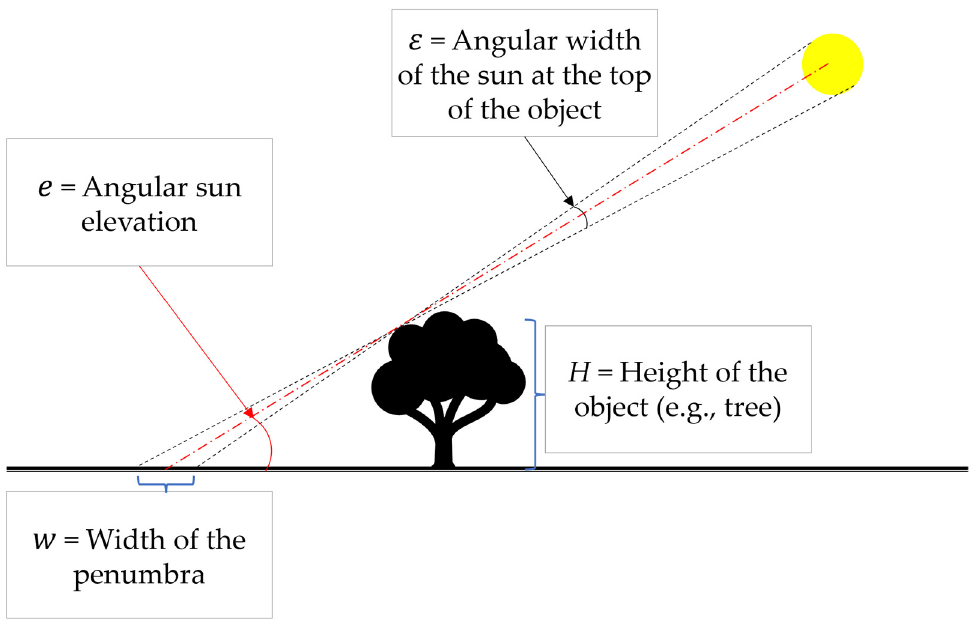
Figure 6. Theoretical estimation of the penumbra width, assuming a flat terrain without other objects where the shadow is projected (source: author 1).